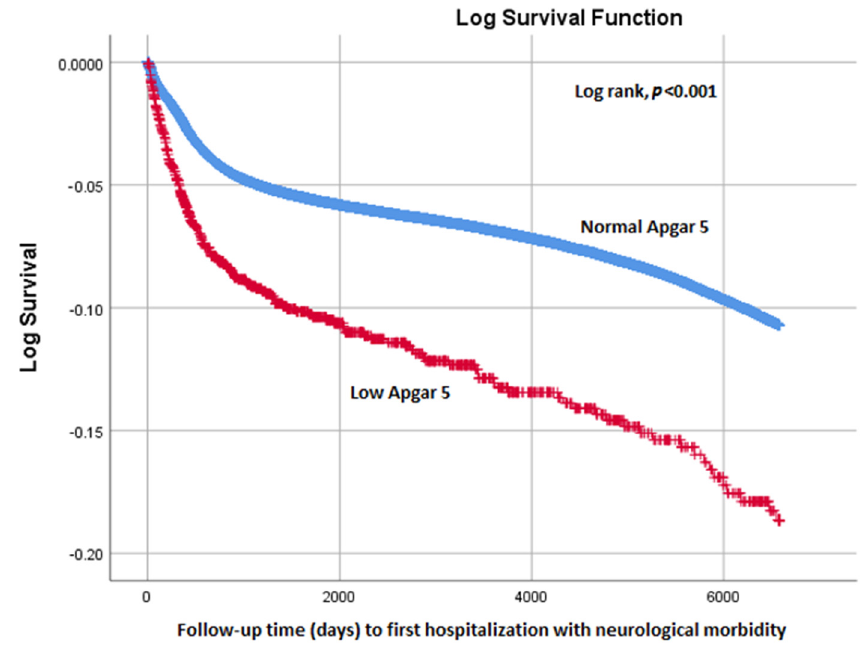
Figure 1. Cumulative survival by study group.